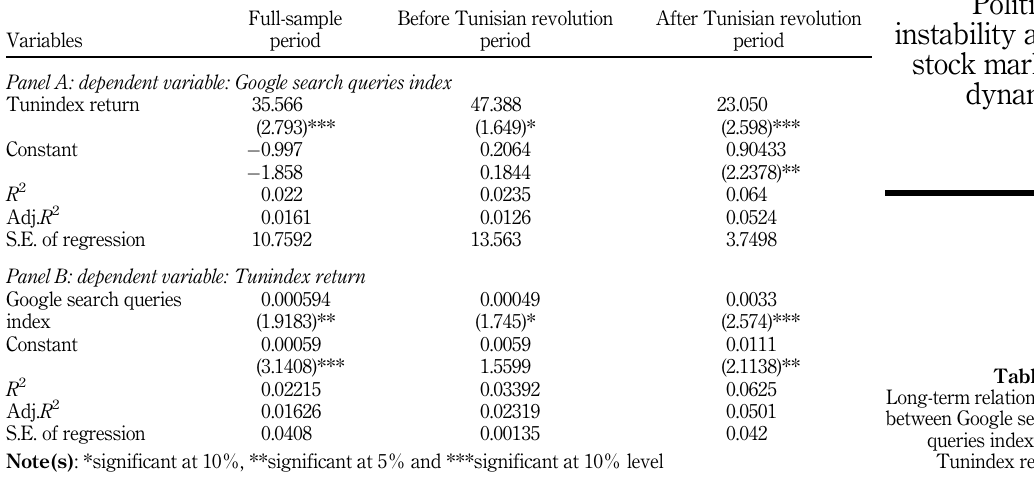
Table 2. Long-term relationship